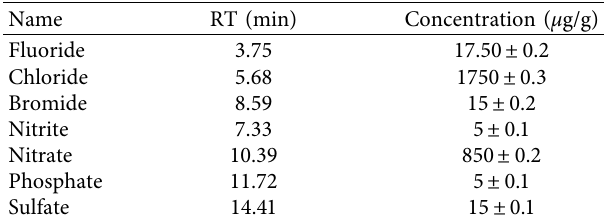
Table 4: Fluoride, chloride, bromide, nitrite, nitrate, phosphate, and sulfate contents of tunichrome released from Phallusia nigra Persian Gulf marine